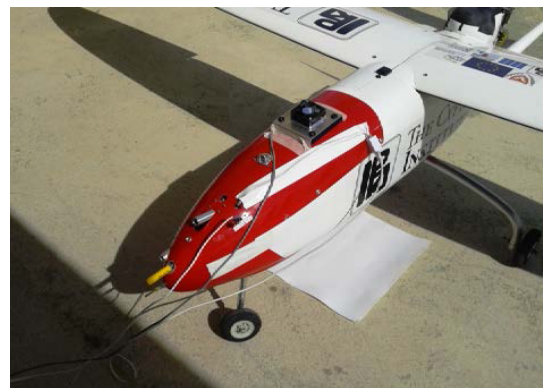
Figure 2. Photograph of the UAV of the Cyprus Institute used for the measurements reported in this